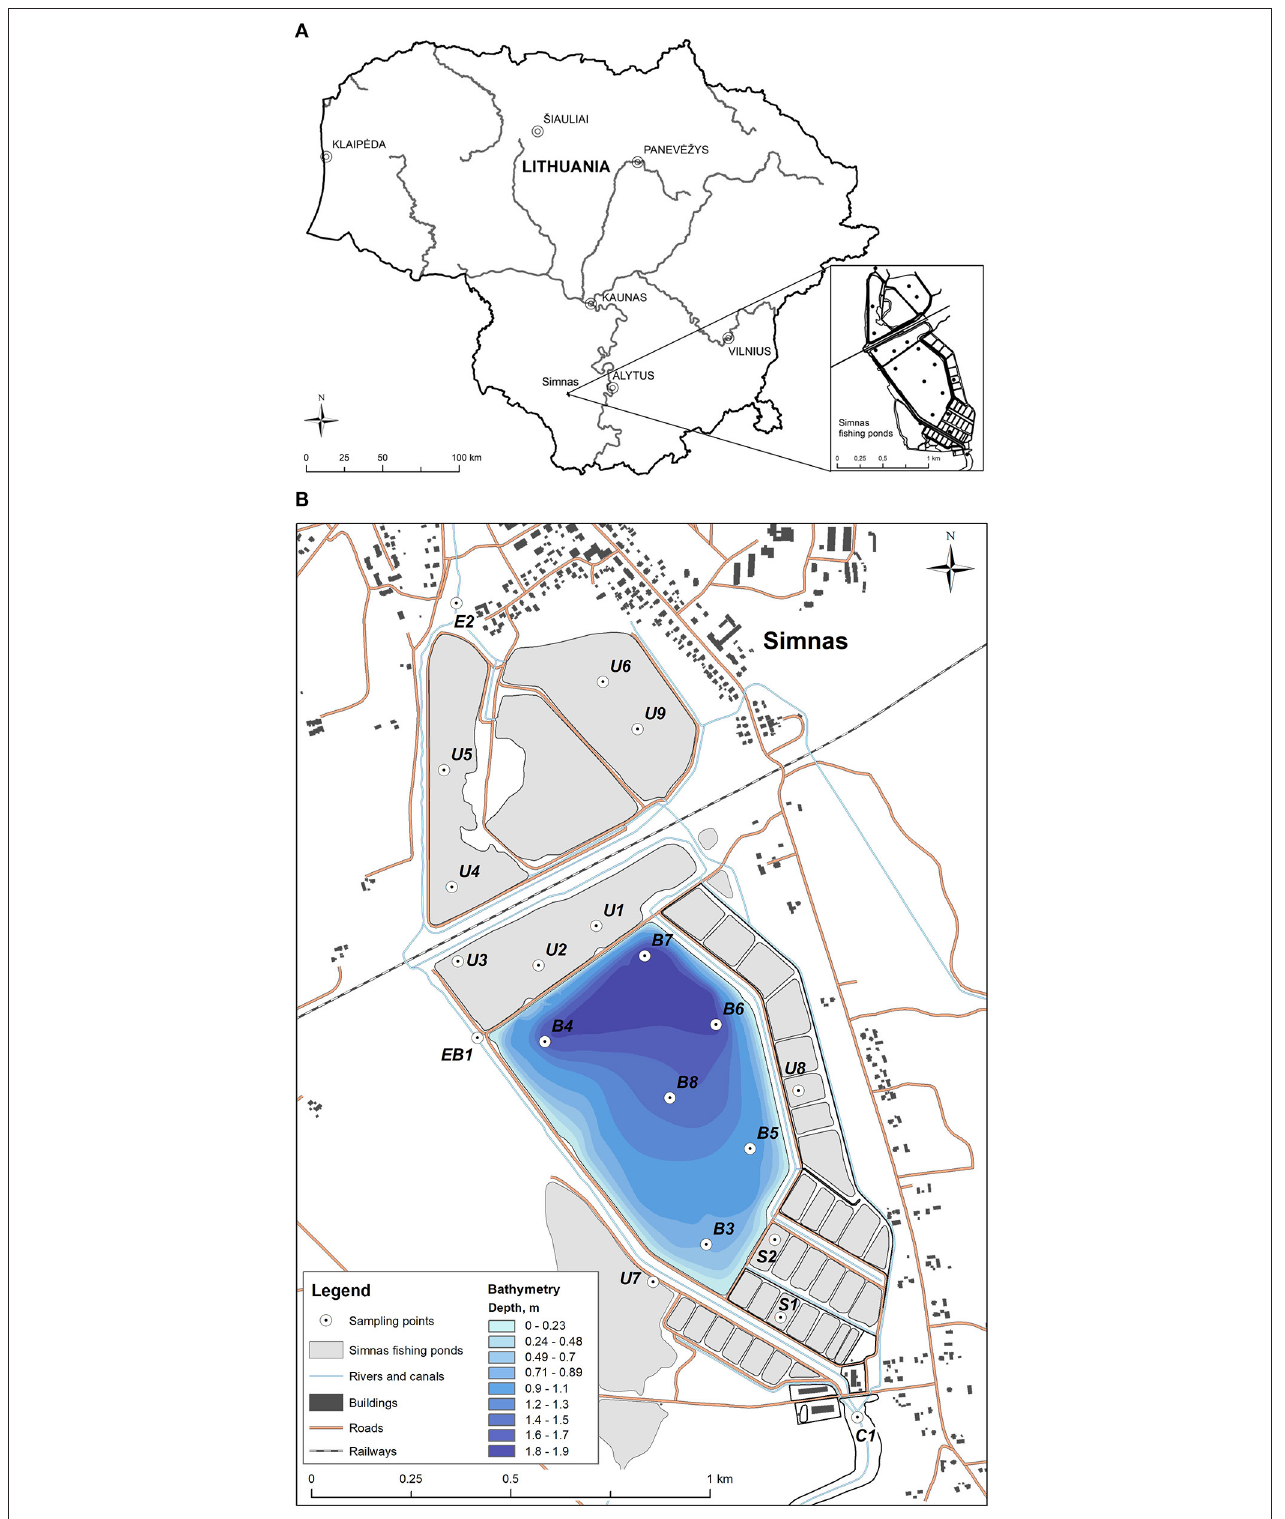
FIGURE 1 | The sampling points in Simnas fishing ponds. (A) The location of Simnas fishery ponds in Lithuania, (B) The map of Simnas fishery ponds. Sample collection points are indicated and named in the figure, as well as the legend for the bathymetry measurements.